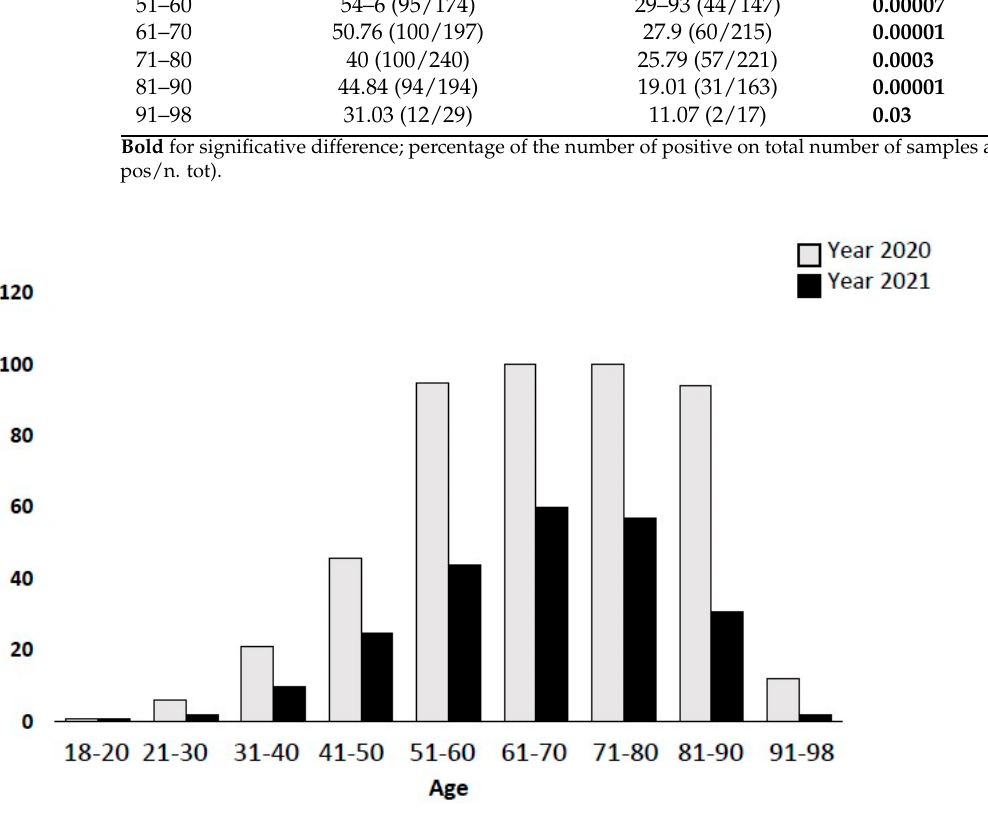
Figure 4. Bar graph showing a strong reduction in positive cases in 2021 compared to 2020. In particular, the Italian vaccination campaign started at the end of 2020 leading to a reduction of 64.6% of positive cases in the elderly population (>80 years old).